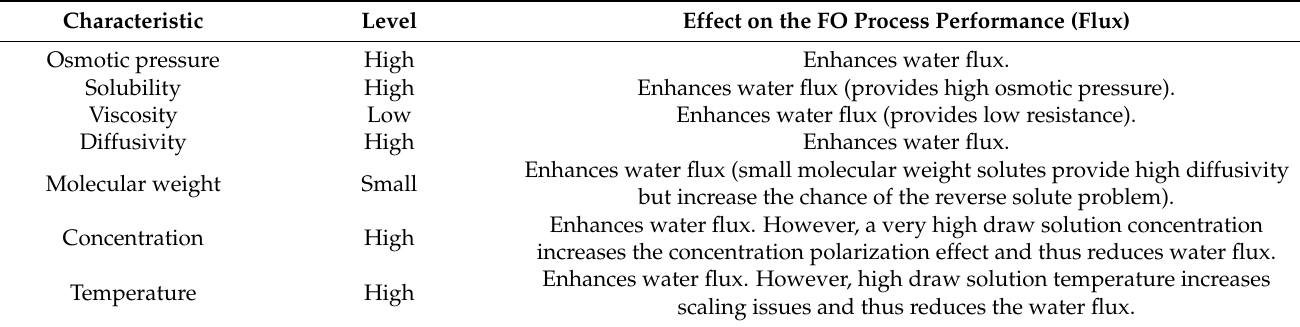
Table 2. Draw solution characteristics and their effect on membrane water flux [14,80] (Permissions No. 5322091417145 and No.